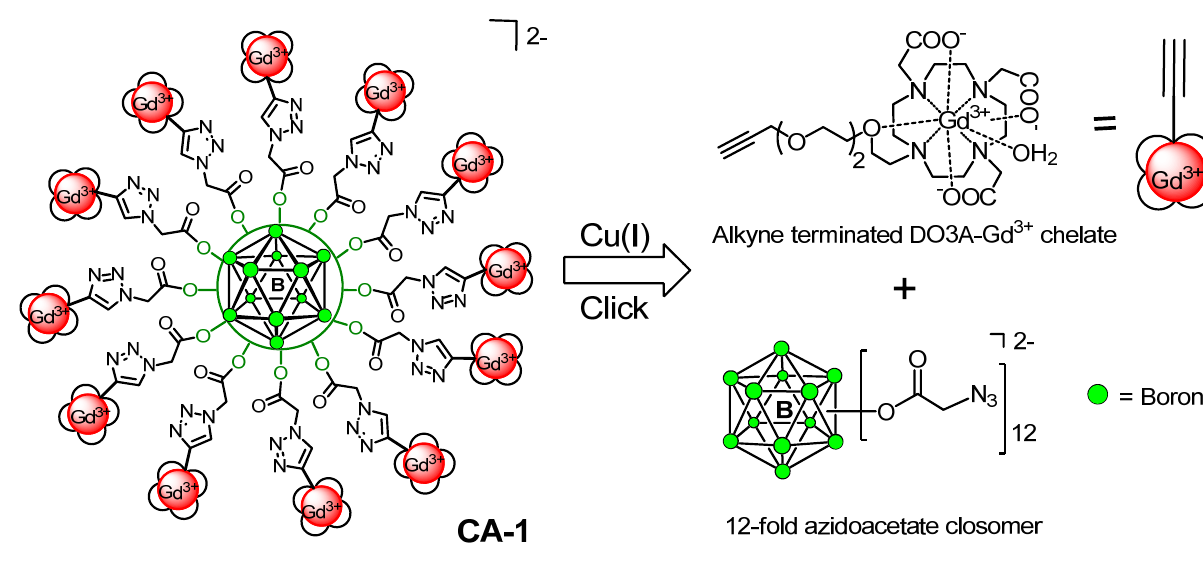
Figure 1. Schematic representation of click assisted synthesis of a [ closo -B supporting 12 copies of a Gd 3+ -DOTA